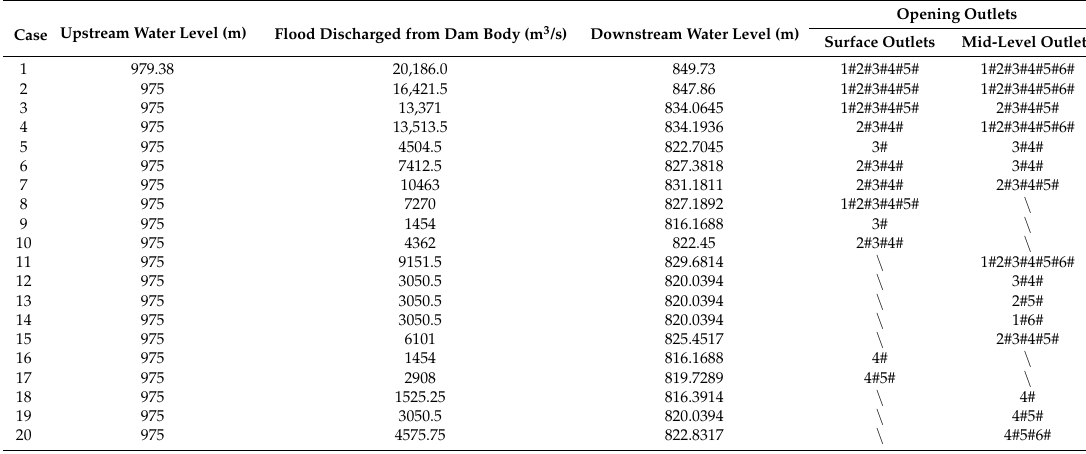
Table A1. All of the flood discharge operating conditions involved in the model